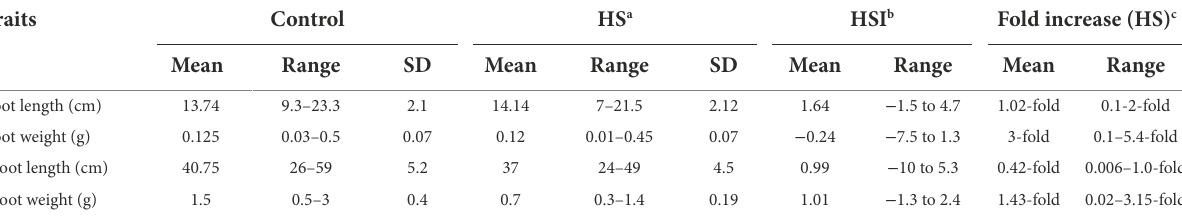
TABLE 1 Descriptive statistics of seedling traits of historical wheat cultivars at seedling stage under control and heat stress condition.